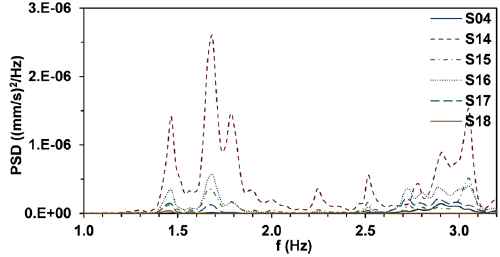
Figure 12. PSDs of S04-S18 in configuration C2.